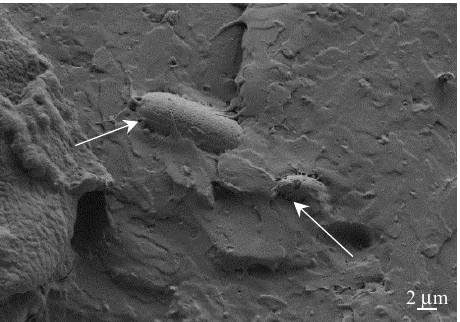
Figure 5. FESEM image (2500×) of the surface of a PLA/DE sample obtained after impact test.